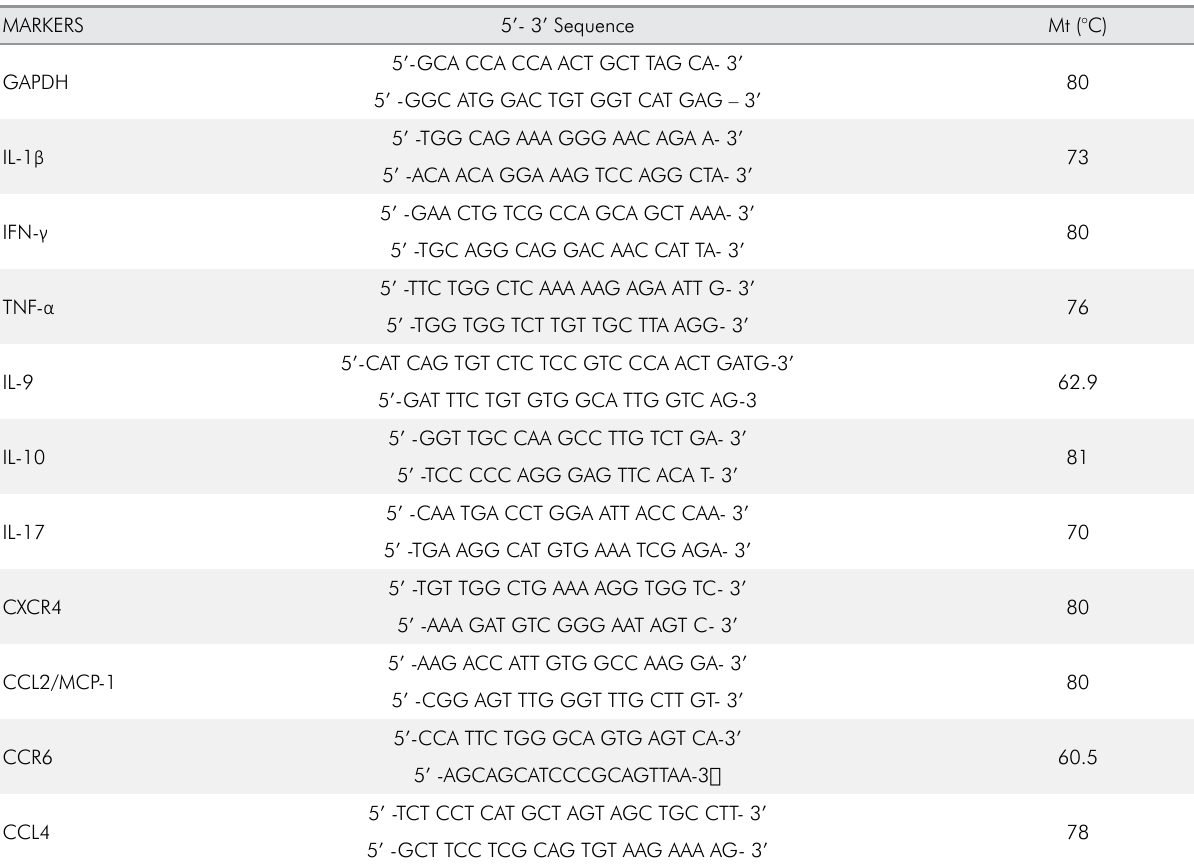
Table. Primer sequences.